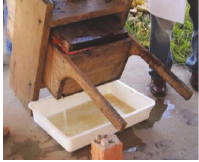
Figure 1: Stages for obtaining cocoa’s residual